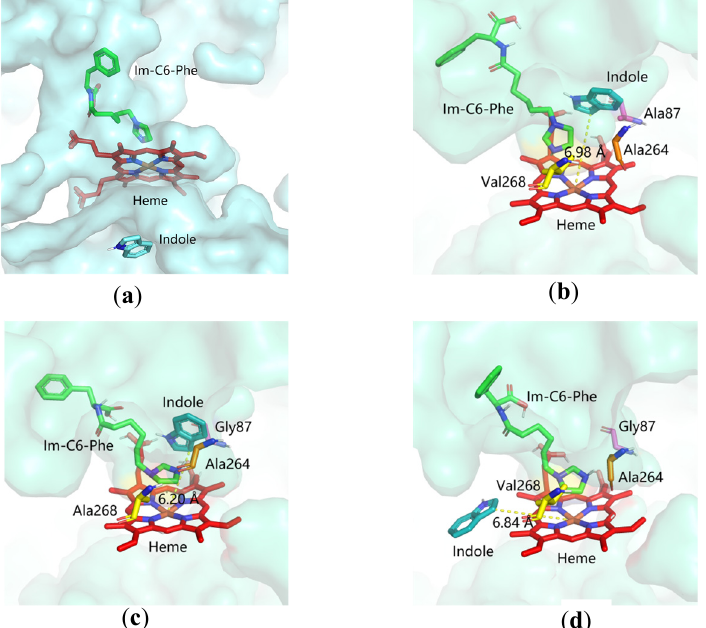
Figure 7. The docking simulation of indole to the active site of ( a ) WT, ( b ) F87A/T268V, ( c ) F87G/T268A, and ( d ) F87G/T268V P450BM3 mutants. Indole (cyan), heme (red), and DFSM (green) are represented as stick models. The amino acid residues at positions 87, 264 positions and 268 positions are shown in purple, orange and yellow,